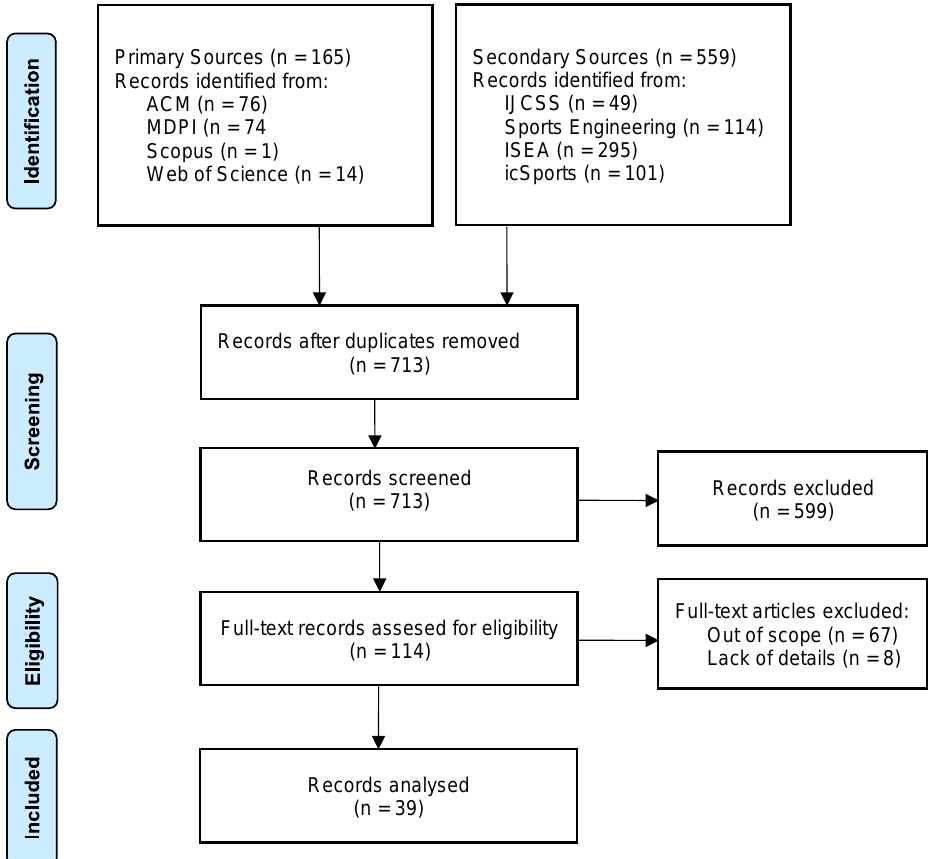
Figure 4. Illustration of the stages of the